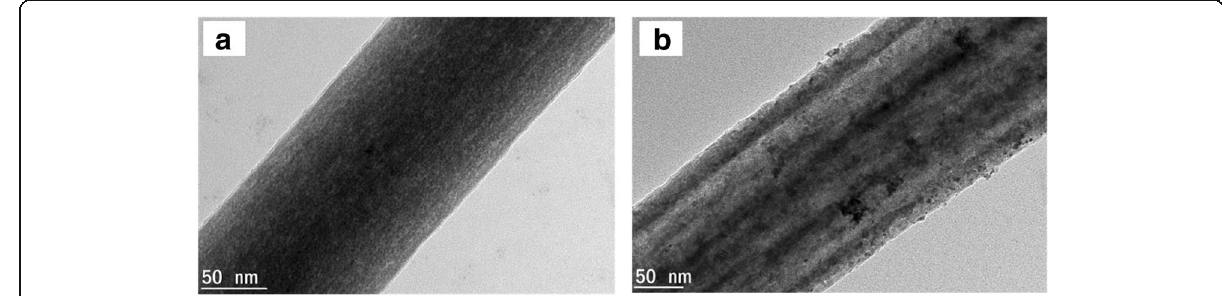
Fig. 11 TEM images for prepared a TiO 2 -CNF catalyst support and b PtRu/TiO 2 -CNF